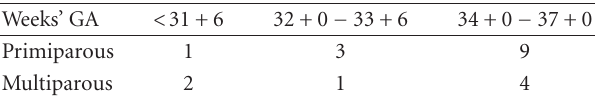
Figure 2: Percentage distribution of maternal fT4 serum level at first consultation subdivided into lower third, middle third and upper third of the reference range for nonpregnant women ( n = 450). Table 1: Numbers of preterm births plotted on gestational week and parity status in the study group ( n = 450).